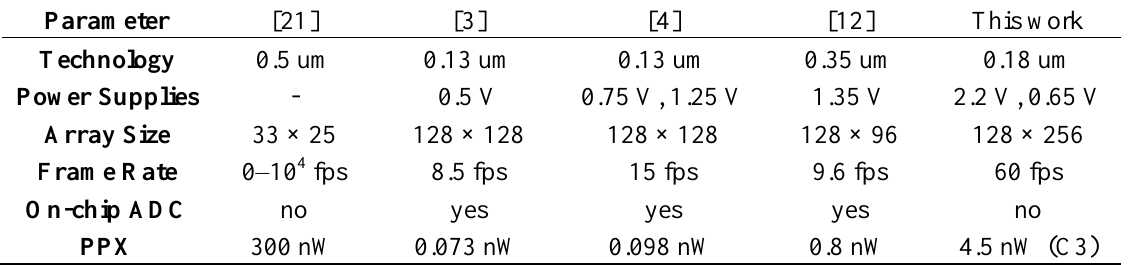
Table 3. Comparison of the presented design and other related works in the field.